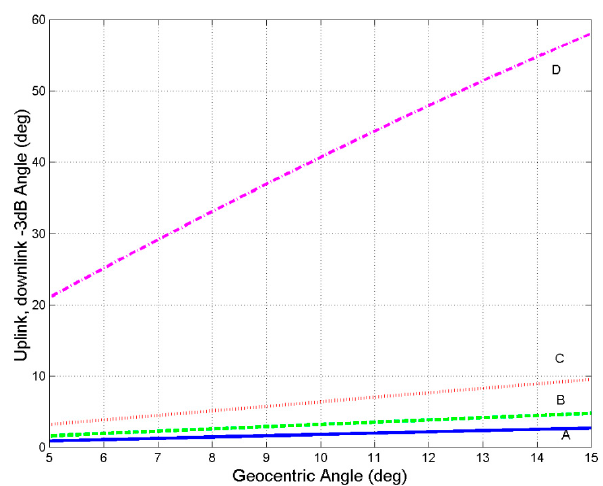
Figure 3. Up − link, down − link and service area angle ( −3 dB) of the GeoSurf constellation design, as a function of the geocentric angle 𝜑 . A refers to ℎ = 35,876 km; B to ℎ = 20,000 km; C to ℎ = 10,000 km, D to ℎ = 1500 km.